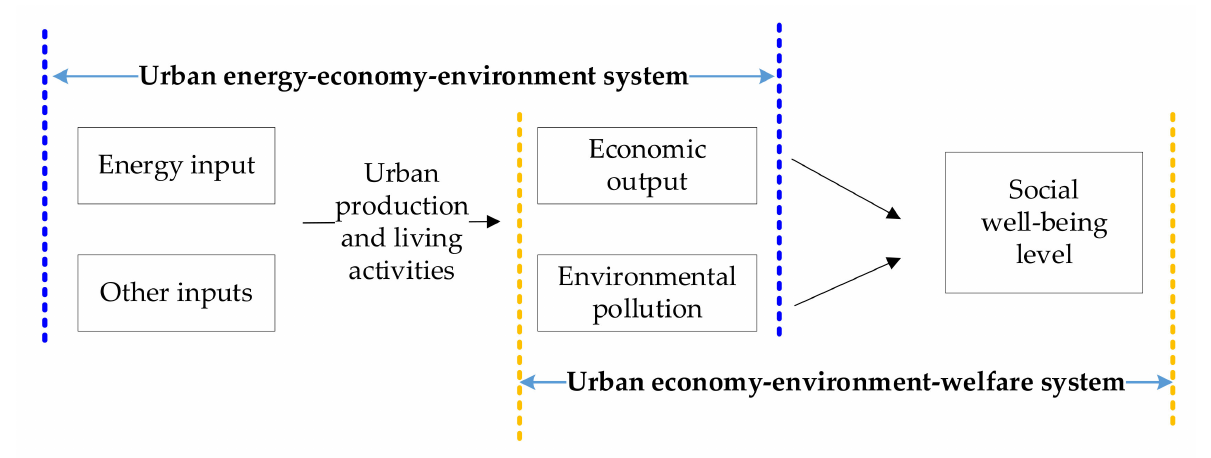
Figure 4. The evolution direction of the conceptual framework of urban energy